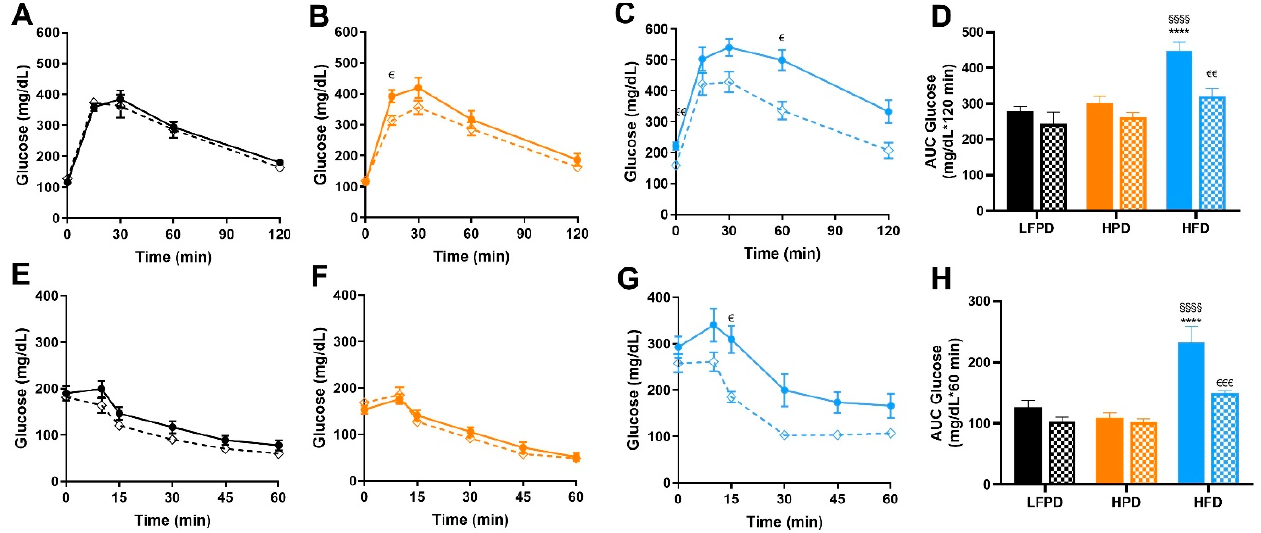
Figure 4. Exercise improves whole-body glucose tolerance and insulin sensitivity in HFD mice. ( A ) Glucose tolerance test exclusion curve for LFPD mice, ( B ) Glucose tolerance test exclusion curve for HPD mice, ( C ) Glucose tolerance test exclusion curve for HFD mice, ( D ) Glucose tolerance area under the curve for all groups of mice ( E ) Insulin tolerance test exclusion curve for LFPD mice, ( F ) Insulin tolerance test exclusion curve for HPD mice, ( G ) Insulin tolerance test exclusion curve for HFD mice, and ( H ) Insulin tolerance area under the curve for all groups of mice after 6 weeks of exercise. N = 7–15 per group. One or two-way ANOVA were used with Tukey’s multiple comparison test (**** p < 0.0001 LFPD vs. HFD, §§§§ p < 0.0001 HPD vs. HFD, € p < 0.05, €€ p < 0.01, €€€ p < 0.001 Sedentary vs. Exercise). Data are expressed as the mean ± SEM.